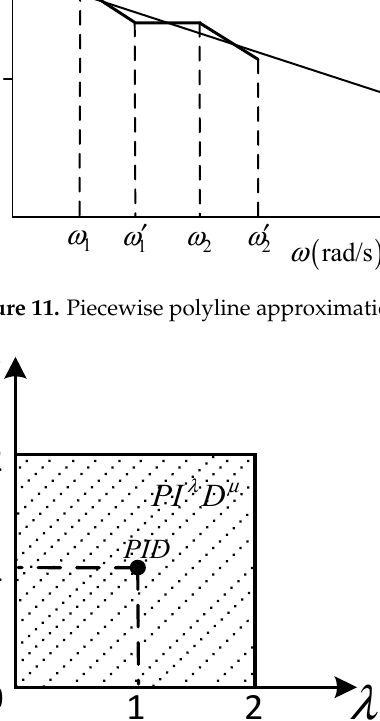
Figure 13. Fractional-order PID control system model.